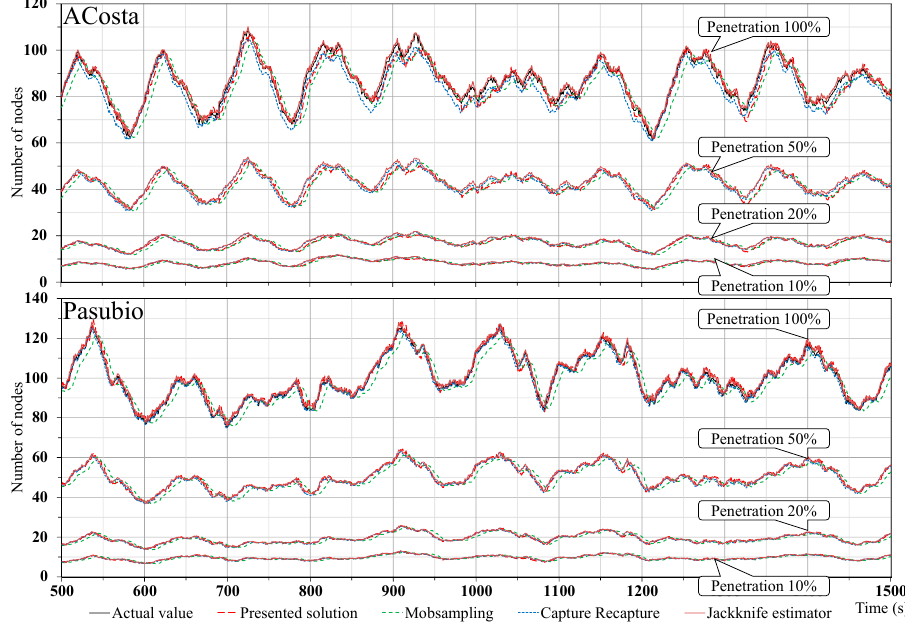
Figure 2. Total number of nodes determined over time by the protocols for different penetration rates in the two tested scenarios.